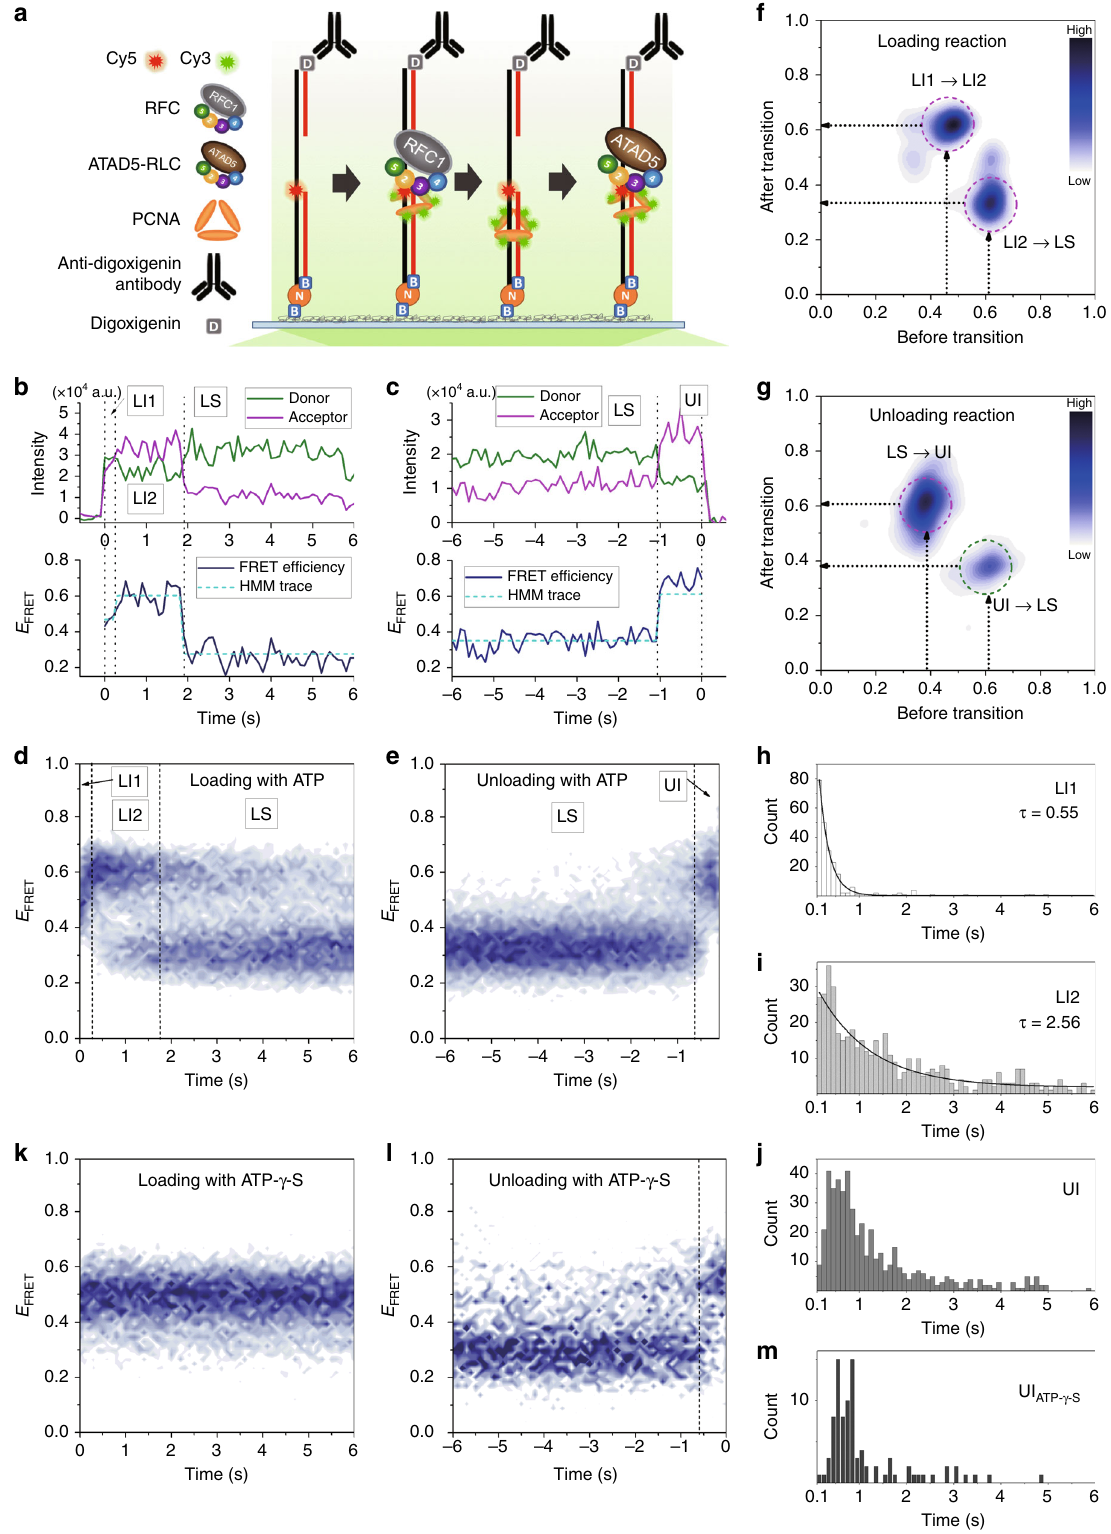
DNA labeling (Supplementary Fig. 4c, j – m). When Cy5 was placed at the 5 ′ -end of the upstream primer, the FRET ef fi ciency remained nearly zero, implying that PCNA remained mostly at the primer-template junction without frequent diffusion into duplex DNA (Supplementary Fig. 4j – k).